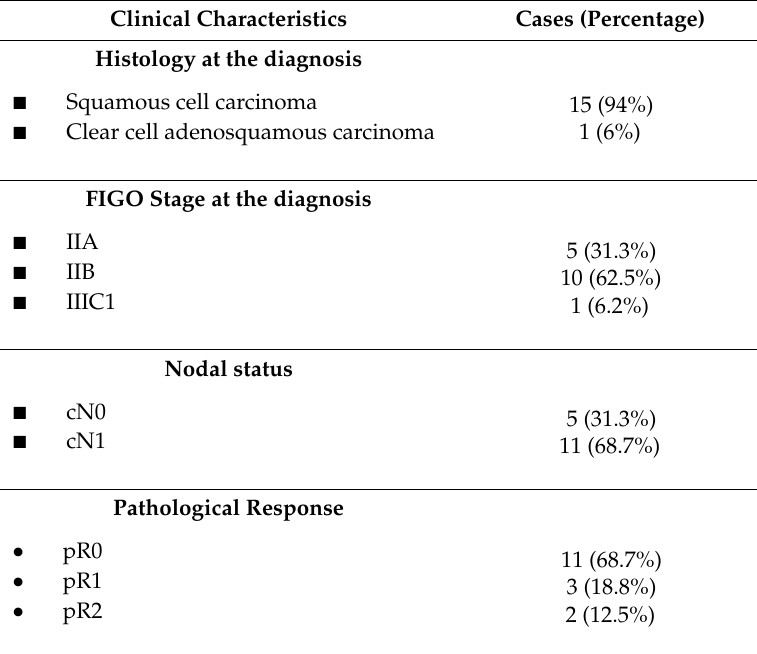
Table 1. Clinical information of the patients enrolled in the